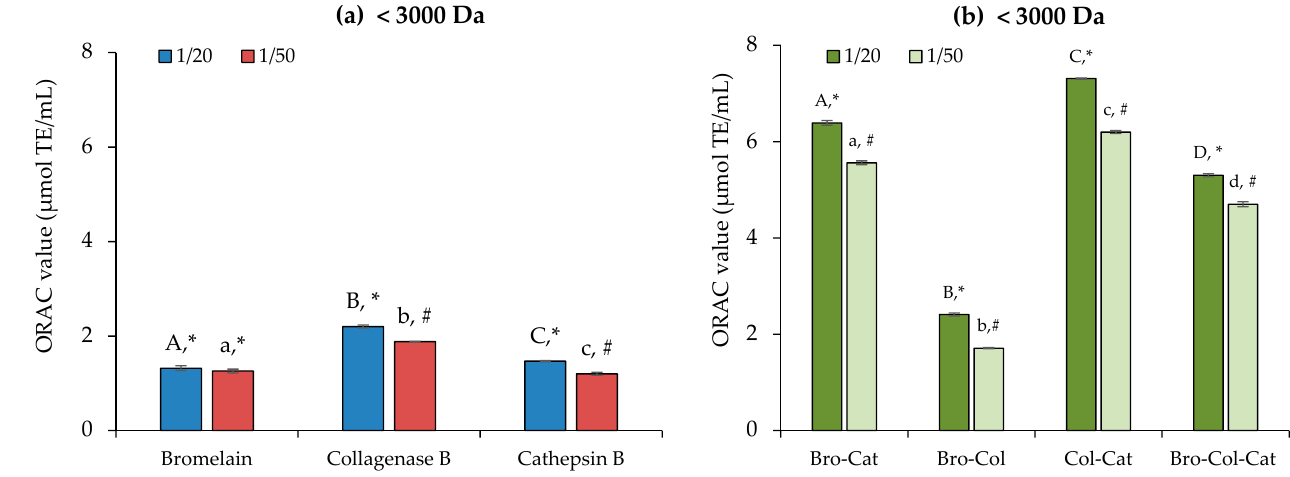
Figure 6. ORAC values for the peptides-minerals complexes, for the ratio E:C 1/20 and 1/50 ( a ), and for complexes mixing ( b ) (Bro = bromelain, Cat = cathepsin B, Col = collagenase B). Columns label interpretation: (i) different uppercase letters indicate differences among enzymes at the E:C 1/20 ratio; (ii) different lowercase letters indicate differences among enzymes at the E:C 1/50 ratio; (iii) different symbols indicate differences between E:C ratios.